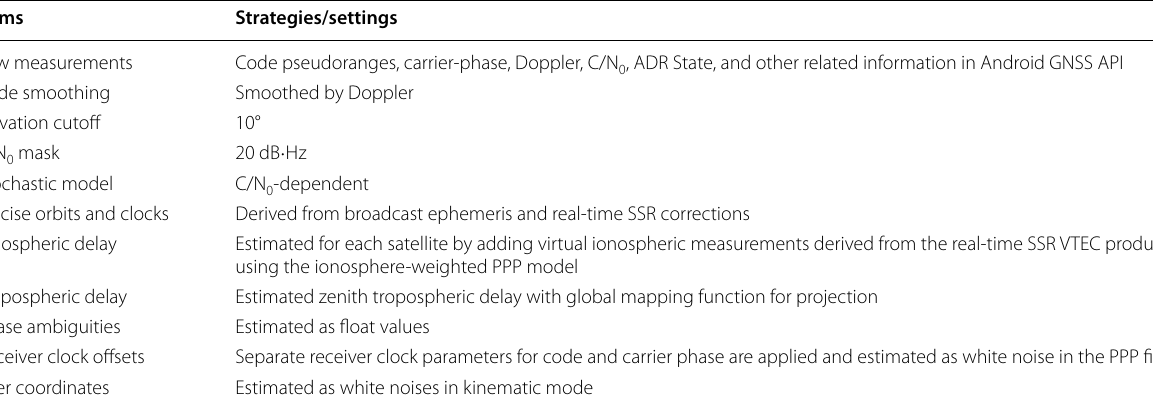
Table 5 Data processing strategies and settings in real-time PPP with smartphones